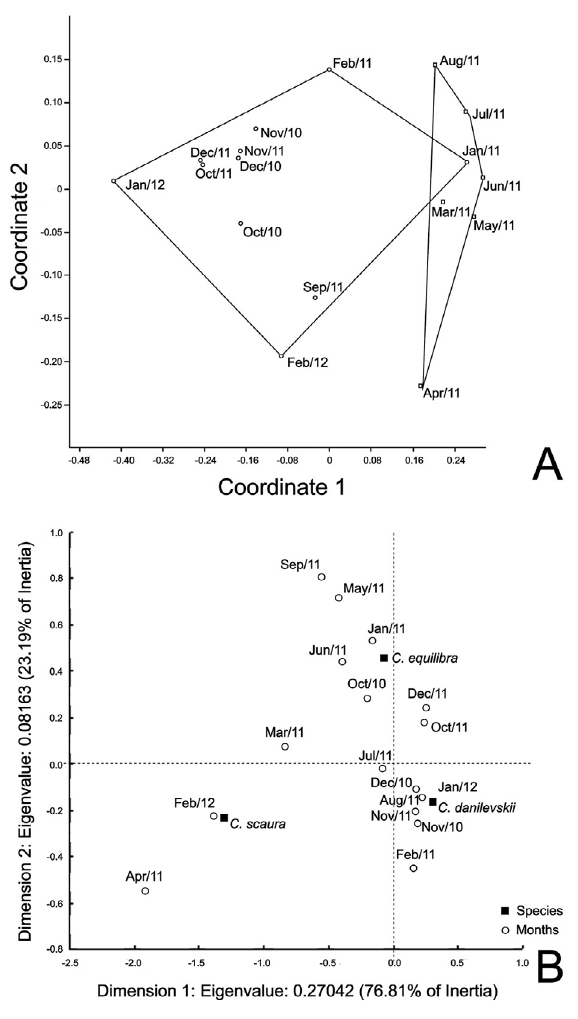
Fig. 6. – The plots of the non-metric multi-dimensional scaling analysis (A) and the correspondence analysis (B), based on the density of the caprellid species and the Sargassum biomass in the studied months in the Ubatuba region, southeastern coast of